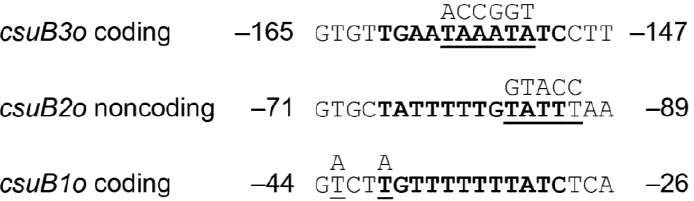
Figure 3. Sequence alignment of Rns binding sites. Within each DNase I footprint, sequences similar to the 12 bp Rns binding site motif were identified and are shown in bold. Nucleotides selected for site-directed mutagenesis are underlined and the mutations are shown above each sequence. Numbering is relative to the Rns-dependent transcription start site.